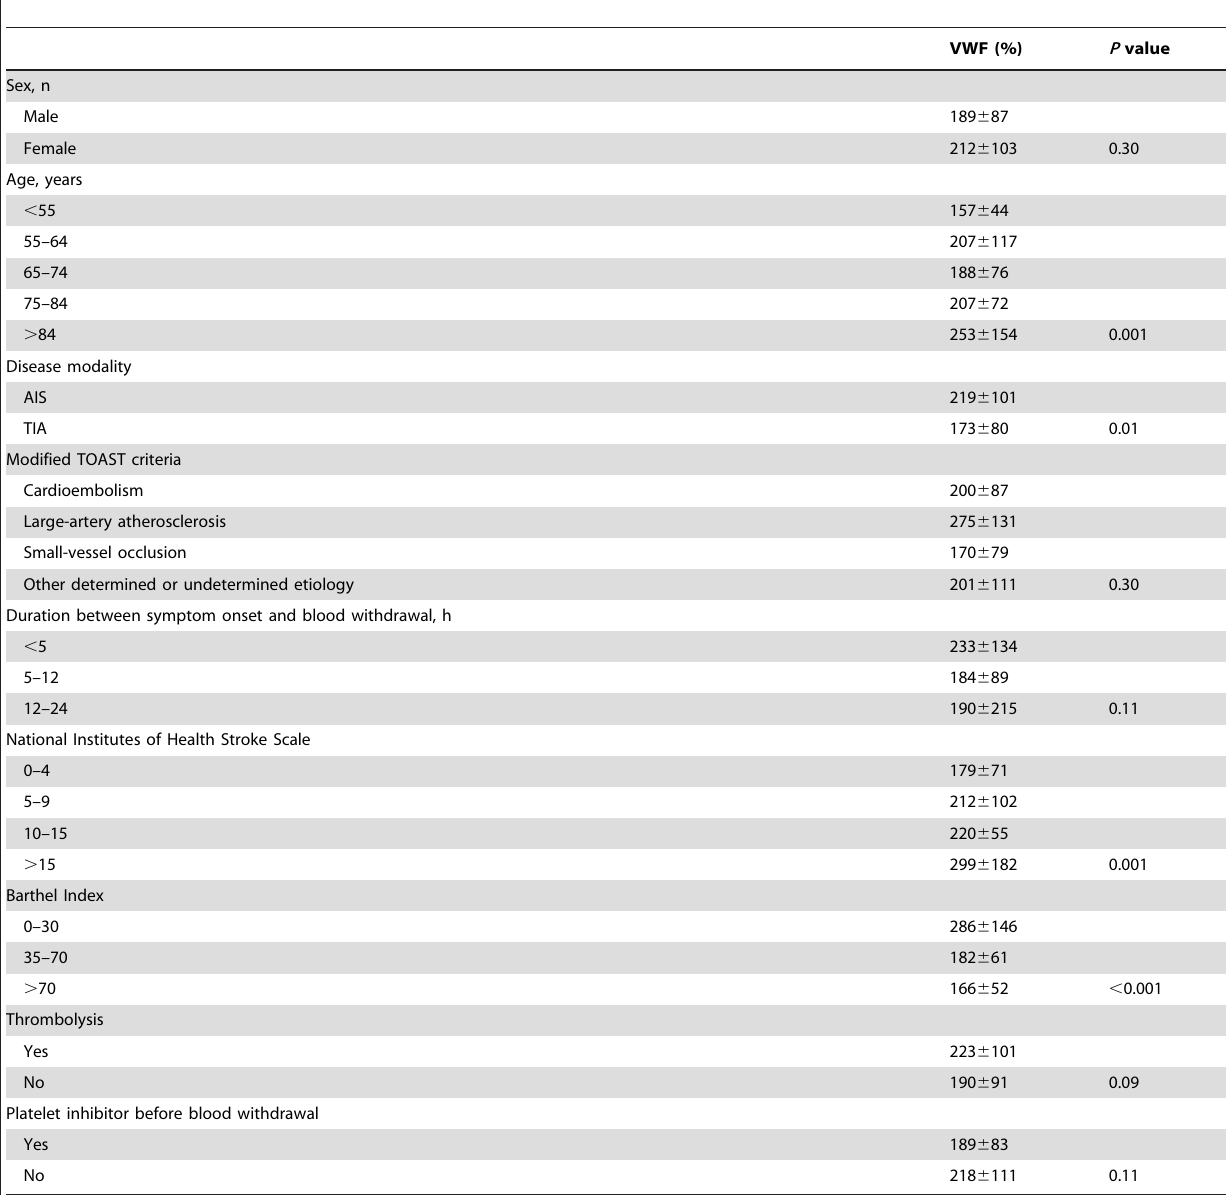
Table 2. Predictors of von Willebrand factor (VWF) levels in acute ischemic stroke (AIS)/transitory ischemic attack (TIA) patients by univariate analysis.